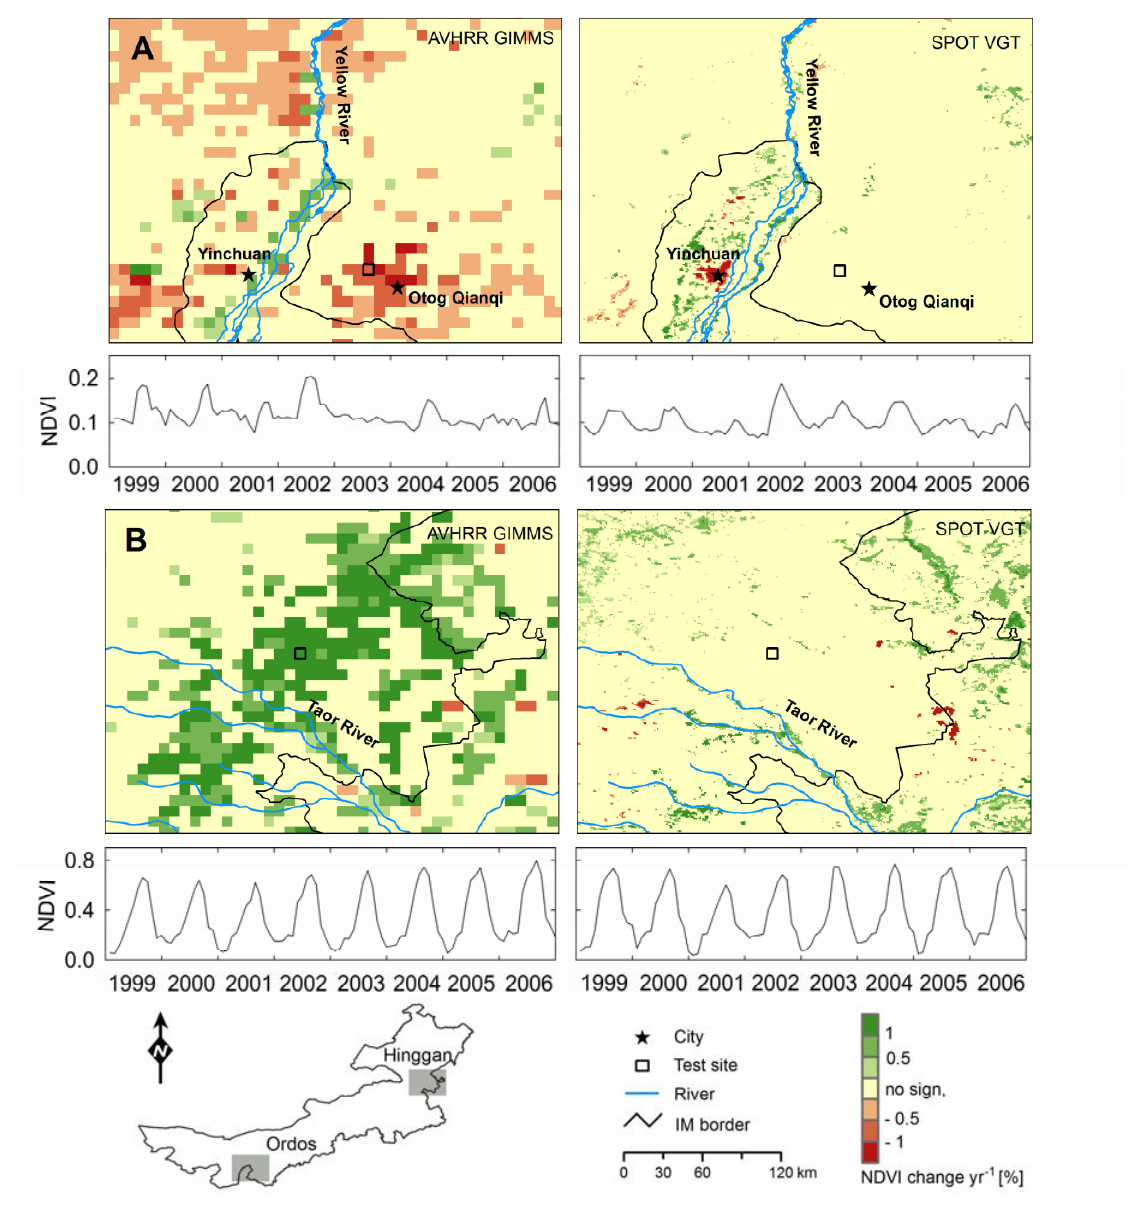
Figure 6. Maps of Sen’s slope for AVHRR GIMMS and SPOT VGT from 1999 to 2006 in Ordos ( A ) and Hinggan ( B ). NDVI time series for a sample location in Ordos and Hinggan (below respective